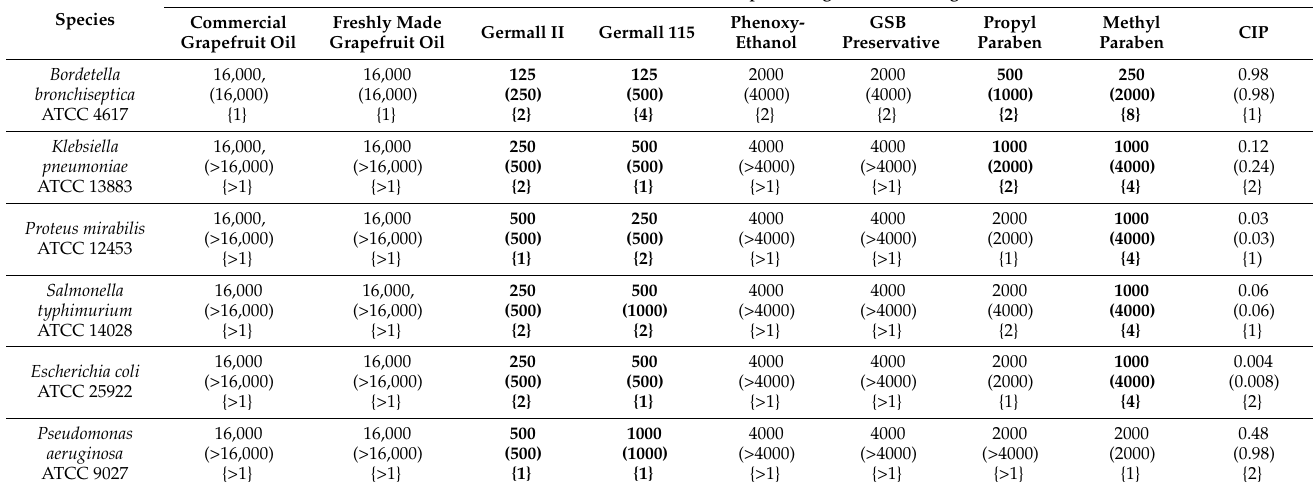
Table 3. The activity data of tested compounds expressed as MIC ( µ g/mL), MBC ( µ g/mL), and MBC/MIC ratio against the reference strains of Gram-negative